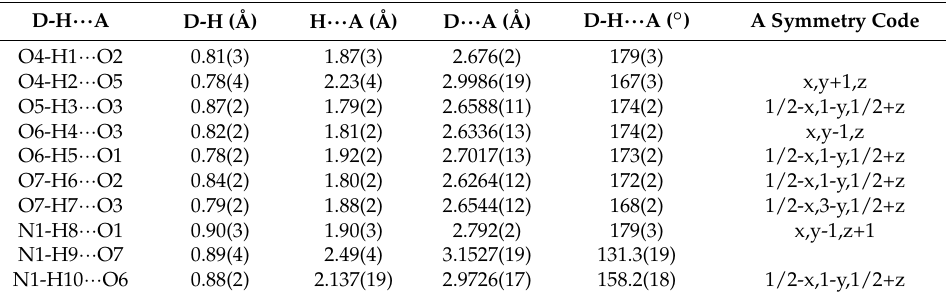
Table 3. Hydrogen-bonding geometry in